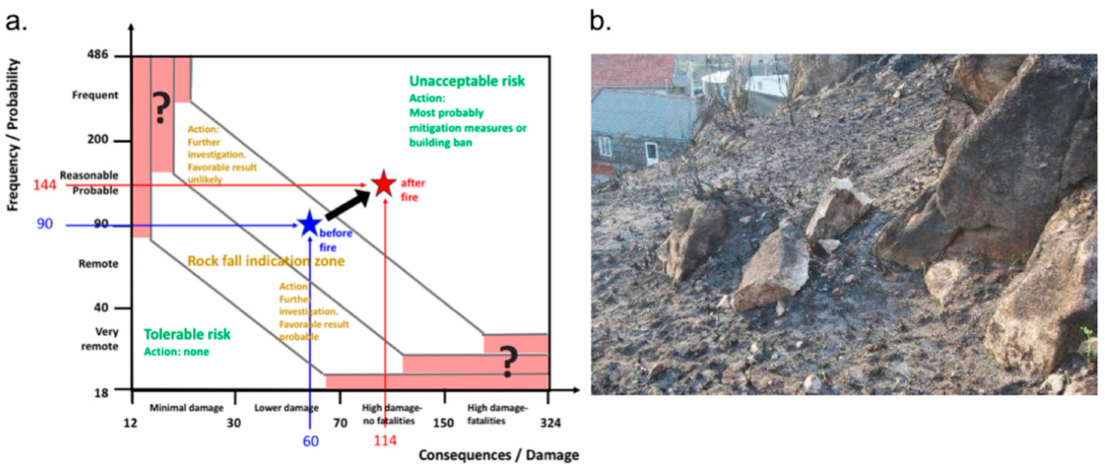
Figure 9. ( a ) Diagram proposed by Mölk et al. [120] for analyzing frequency/probability vs. consequence/damage. ( b ) Freshly fragmented block in the lower part of the slope after the